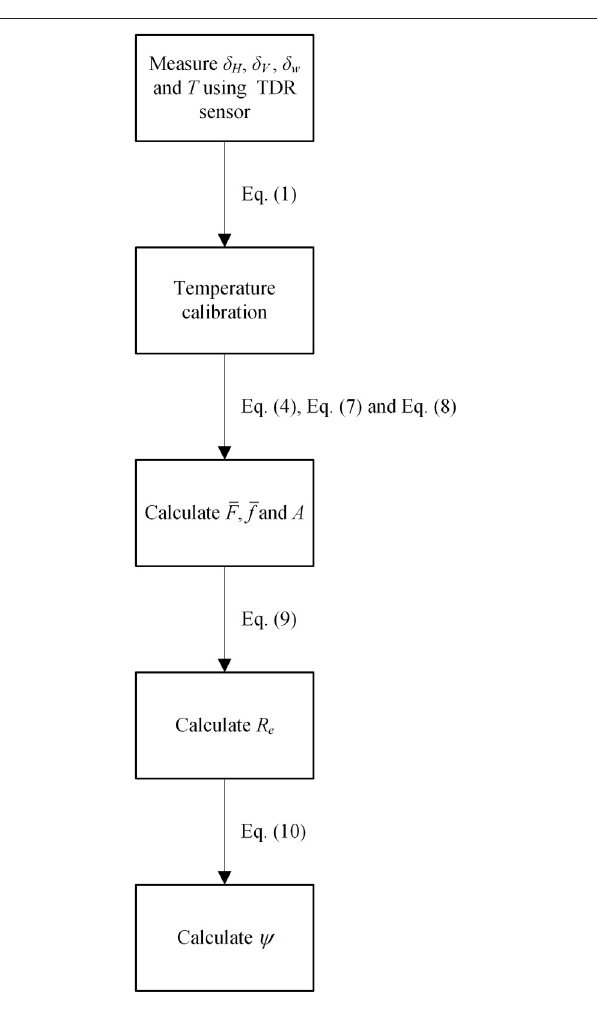
FIGURE 10 | Flowchart to obtain matrix suction using conductivity- matrix suction prediction